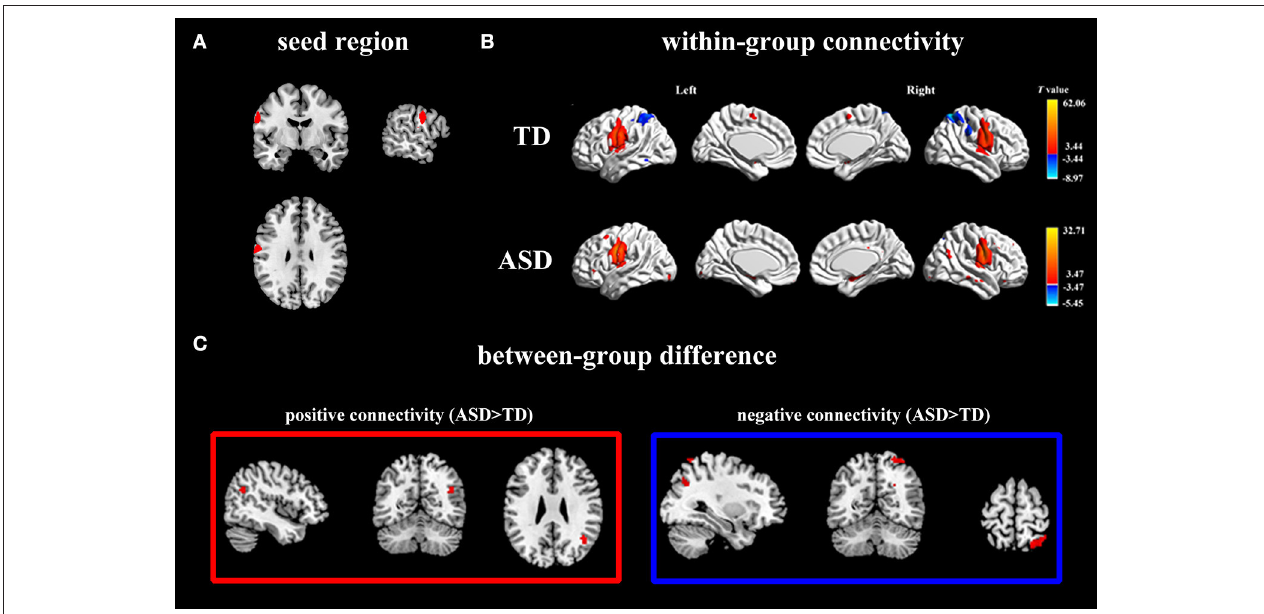
FIGURE 2 | Positive and negative functional connectivity maps with seed of left PCG. (A) The left PCG used as seed region. (B) Within-group connectivity maps of TD and ASD ( p < 0.05). Red areas depict voxels with positive correlations, whereas blue areas depict voxels with negative correlations. (C) Between-group differences in functional connectivity maps (ASD > TD, p < 0.05). The left pictures in the red frame depict voxels of greater positive connectivity with the seed region for the ASD group, while the right pictures in the blue frame depict voxels of greater negative connectivity with the seed region for the ASD